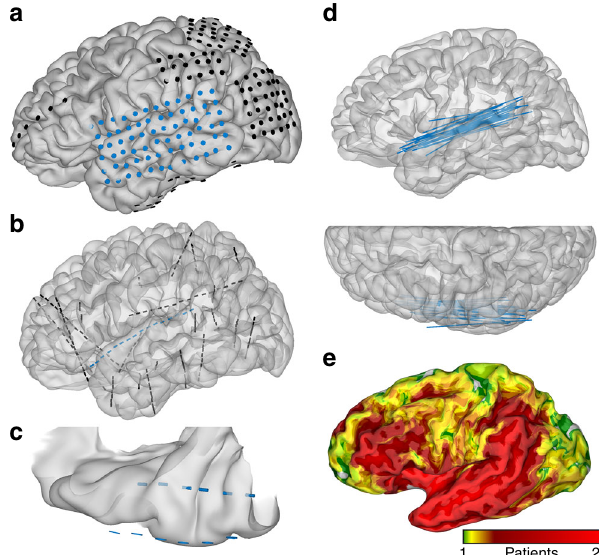
Fig. 1 Supratemporal depth probe trajectory and complete coverage map. Electrodes represented relative to cortical models. a Grid electrodes localized relative to patient-speci fi c cortical model, including a lateral temporal grid. b Same patient with a second implant using stereotactic depth electrodes, including an anteroposterior supratemporal trajectory. c Dorsal view of the supratemporal plane in the same patient with depth electrodes in Heschl ’ s gyrus and planum temporale, as well as the closest grid electrodes over lateral superior temporal gyrus. d All anteroposterior supratemporal trajectories superimposed in Talairach space relative to the MNI27 atlas. e Recording zone density from all electrodes (37 patients, 838 grid electrodes, 6669 depth electrodes) on an in fl ated MNI27